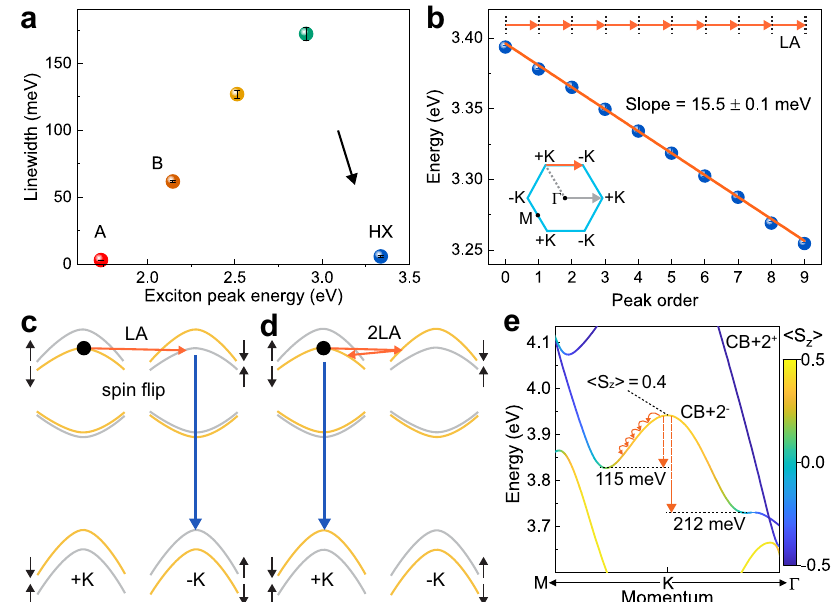
Fig. 2 Excitonic linewidths, equidistant phonon progression, and phonon scattering mechanisms in high-lying exciton PL. a Energies and linewidths (full width at half maximum) of the prominent excitonic states seen in the PL of hBN encapsulated monolayer WSe 2 . The PL linewidth increases with transition energy until the HX breaks the trend. A summary of the data is given in Supplementary Table 1. The error bars were obtained from peak fi tting. b HX UPL peak positions as a function of peak number. The error bars were obtained from multi-peak fi tting and are below the diameter of the spheres. The fi tted slope of 15.5 ± 0.1 meV corresponds to the calculated longitudinal acoustic (LA) phonon energy (orange arrows) near the K -points, which allows inelastic scattering of electronic states between + K and − K -points. Inset: the momentum change from Γ to + K (gray arrow) equals that from + K to − K (orange arrow). c and d The spin (black arrows) sublevels of conduction and valence bands of single-layer WSe 2 are non-degenerate at the K -points. Momentum- conserving electron – phonon scattering (orange arrows) can involve either one phonon and a spin fl ip ( c ), or a spin-conserving two-phonon double- resonance transition ( d ). e Calculated GW band structure of monolayer WSe 2 of CB + 2 − around the K -point. The color code of the band structure shows the expectation values of the spin operator on the spinor wavefunctions in the out-of-plane direction, i.e., 〈 S z 〉 , in units of _ . The curved arrows illustrate the energy associated with LA-phonon